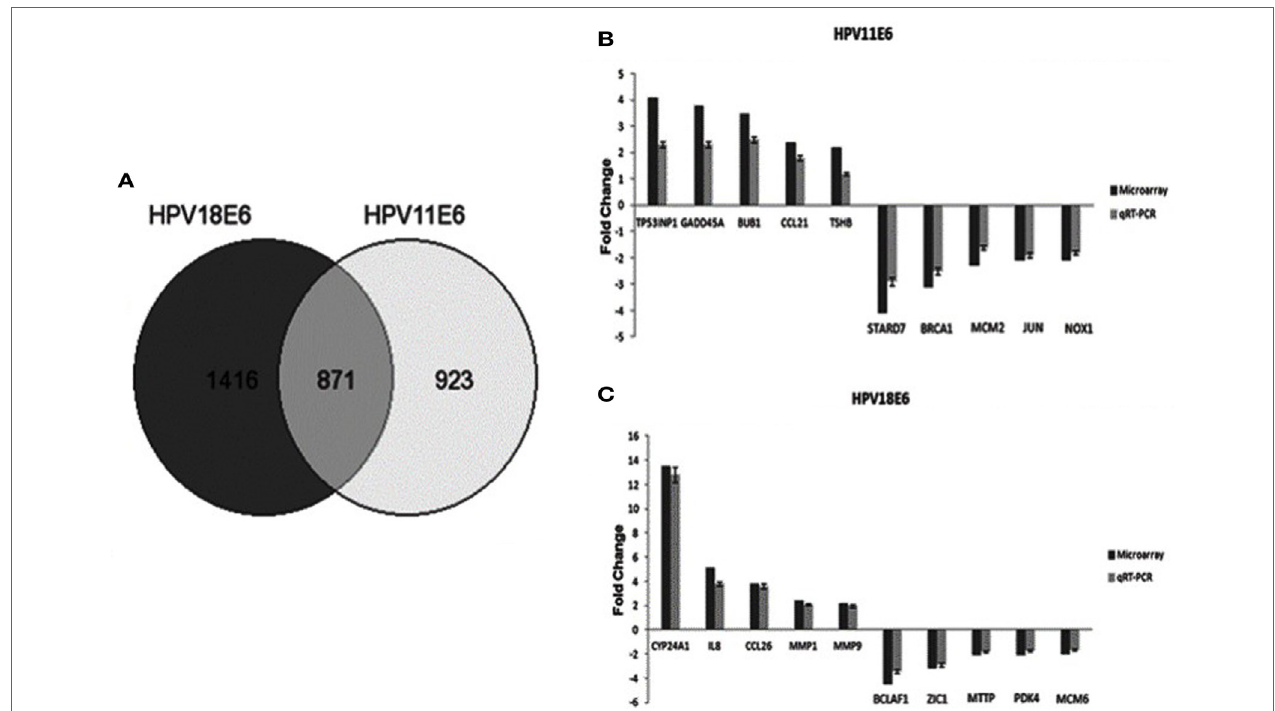
FigUre 4 | The effect of HPVE6 on cellular gene expression patterns. (a) A Venn diagram showing the number of significantly differentially expressed genes (DEGs) (both up- and downregulated). A total of 3,210 genes were significantly differentially expressed, of which 1,416 genes were uniquely deregulated in HPV18E6 cells, while 923 genes were uniquely deregulated in HPV11E6 cells and 871 genes were deregulated by both HPVs compared to the control HaCaT cells. (B) HPV11E6 and (c) HPV18E6, qRT-PCR validation of the microarray data showing the selected top 10 DEGs based on either the extent of up- or downregulation or on their known involvement in cellular transformation. The fold change shown was normalized to GAPDH mRNA levels and qRT-PCR figures represent the average of three replicates for each infection with the error bars indicating